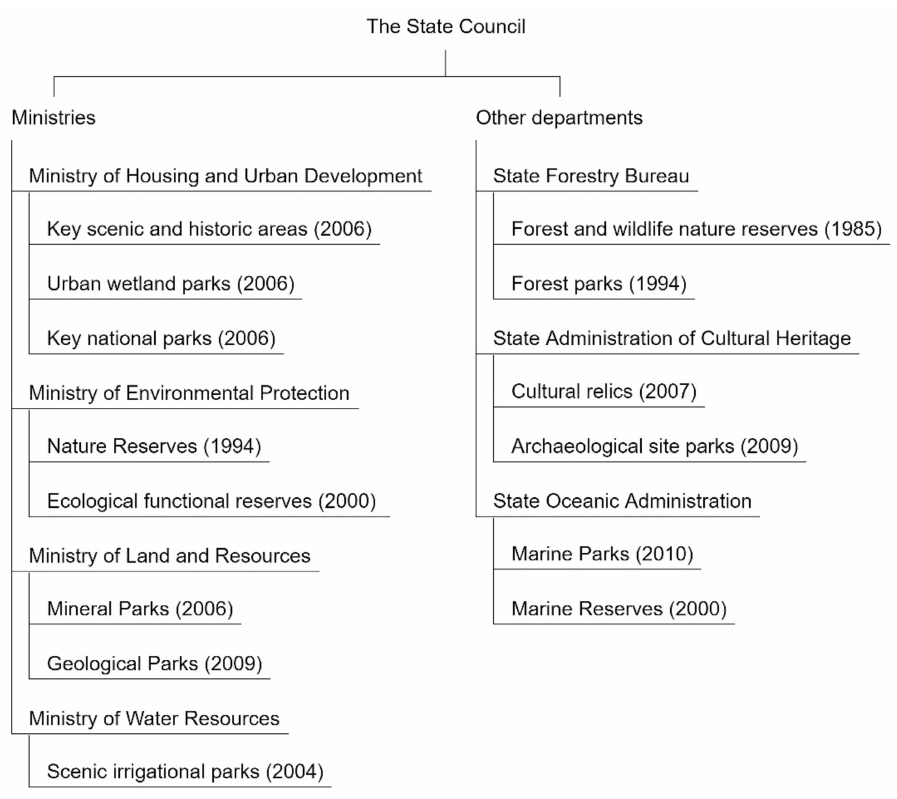
Figure 3. The management system of China’s CPAs. Year denotes the year of establishment. Furthermore, a single CPA can be designated with several titles. For instance, the Jiuzhaigou National Park in Sichuan Province was designated in 2004. Previously, it was defined as the Jiuzhaigou National Nature Reserve in 1978. In 1982, it was designated as part of the Huanglong Temple, and Jiuzhaigou Valley Scenic and Historic Interest